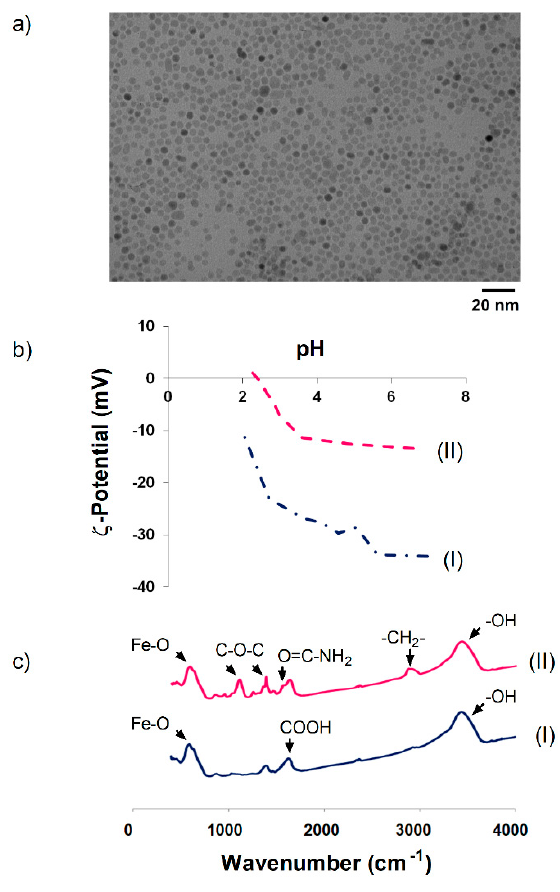
Figure 1. ( a ) Transmission electron microscopy (TEM) images of 10 nm nanoparticles. ( b ) Evolution of ζ -potential as a function of pH. ( c ) FTIR spectra. (I) NP-DMSA, (II) NP-PEG-(NH 2 ) 2(2000) .